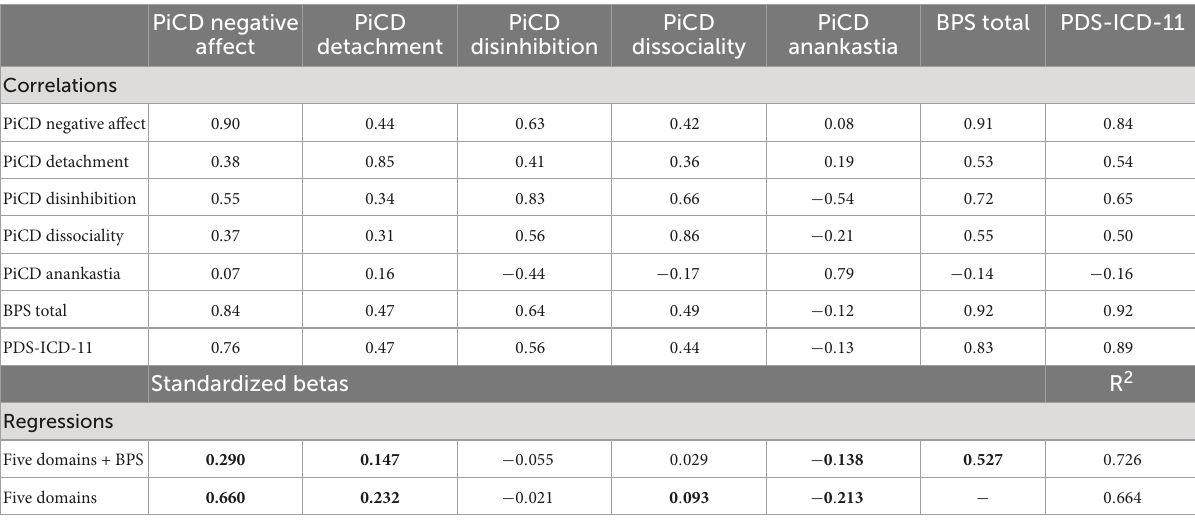
TABLE 1 Pearson’s (lower triangle) and disattenuated correlations (upper triangle) between the ICD-11 system components with alphas in the diagonal, and multiple regressions of severity on personality traits. PiCD negative